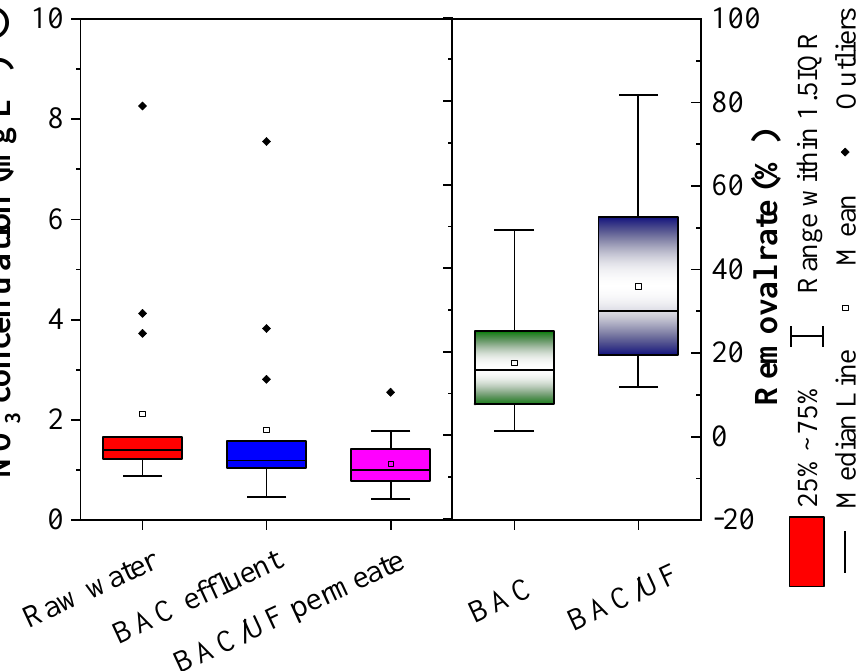
Figure 4. The removal performance of NH 4+ -N, NO 2 − -N, and NO 3 − -N by BAC-UF system: ( a ) NH 4+ -N, ( b ) NO 2 − -N, ( c ) comparison of BAC and BAC-UF for removals of NH 4+ -N and NO 2 − -N, ( d ) NO 3 − -N.